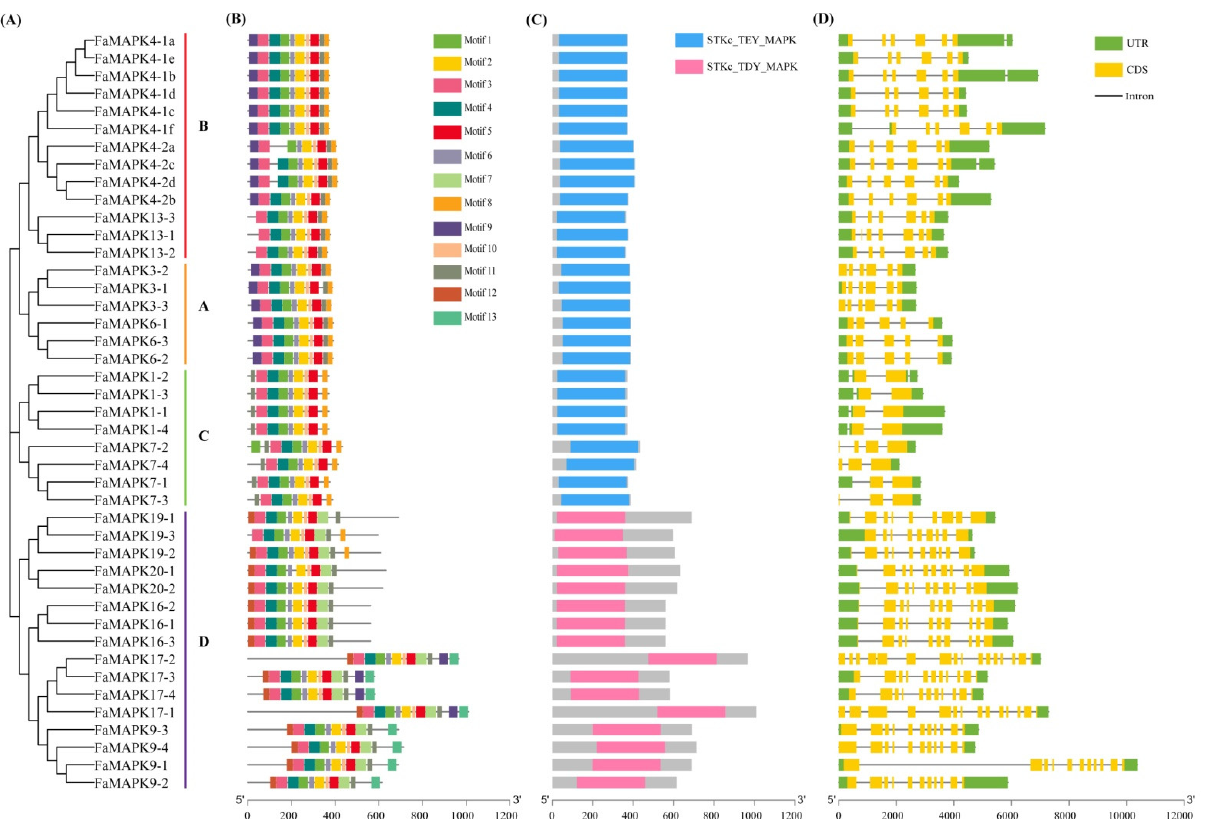
Figure 3. Phylogenetic relationships, conserved protein motifs and gene structure analysis of FaMAPK genes. ( A ) Phylogenetic tree of FaMAPK gene family. ( B ) Distribution of motifs of FaMAPK proteins. ( C ) The conserved domains in FaMAPK proteins. ( D ) Exon–intron structure of FaMAPK genes. FaMAPK